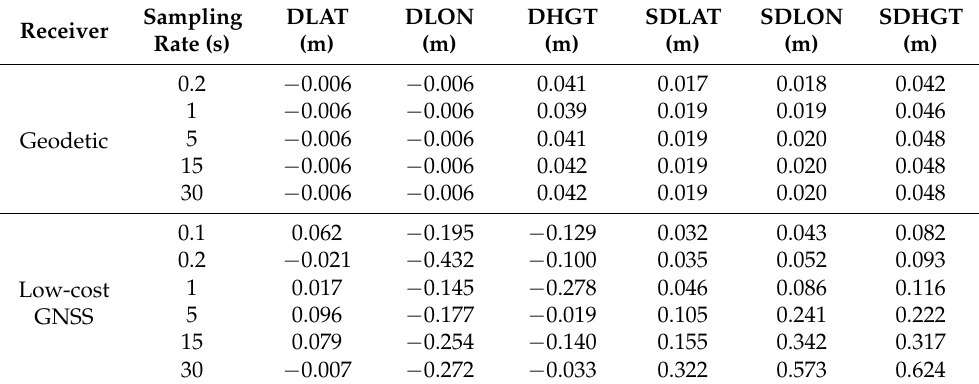
Figure 13. Standard deviation (95%) of estimated positions of low-cost and geodetic receivers at 0.1 and 0.2 s respectively, by processing with PPP-kinematic mode. Table 3. Differences and Standard deviation obtained at different sampling rates for the PPP- kinematic